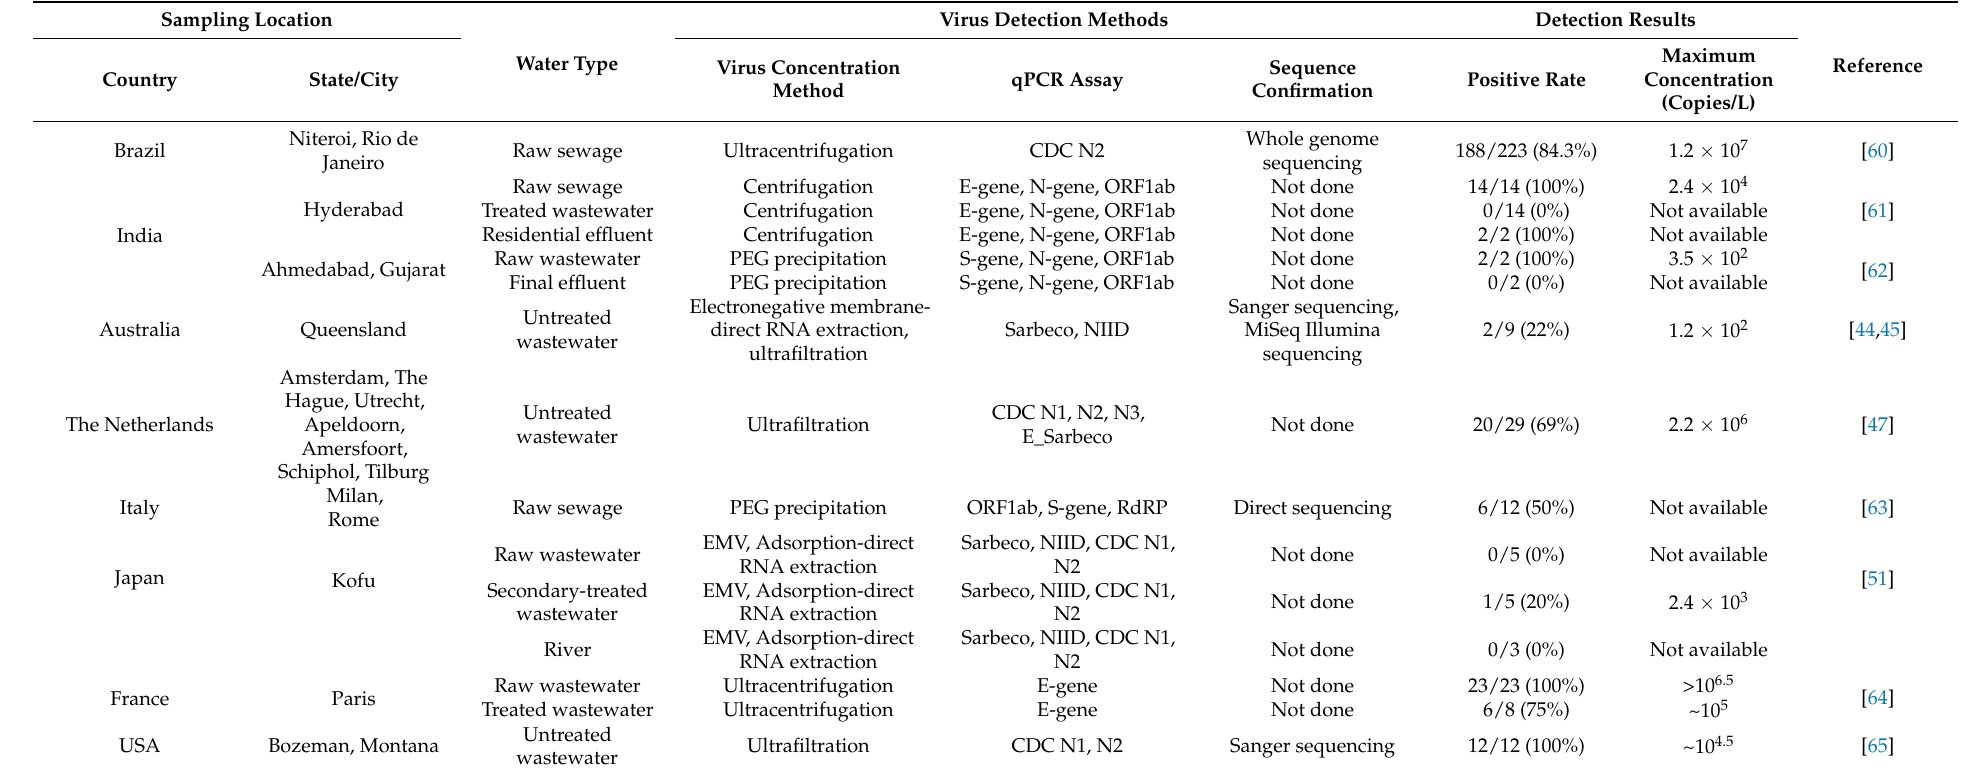
Table 1. RNA from both treated and untreated